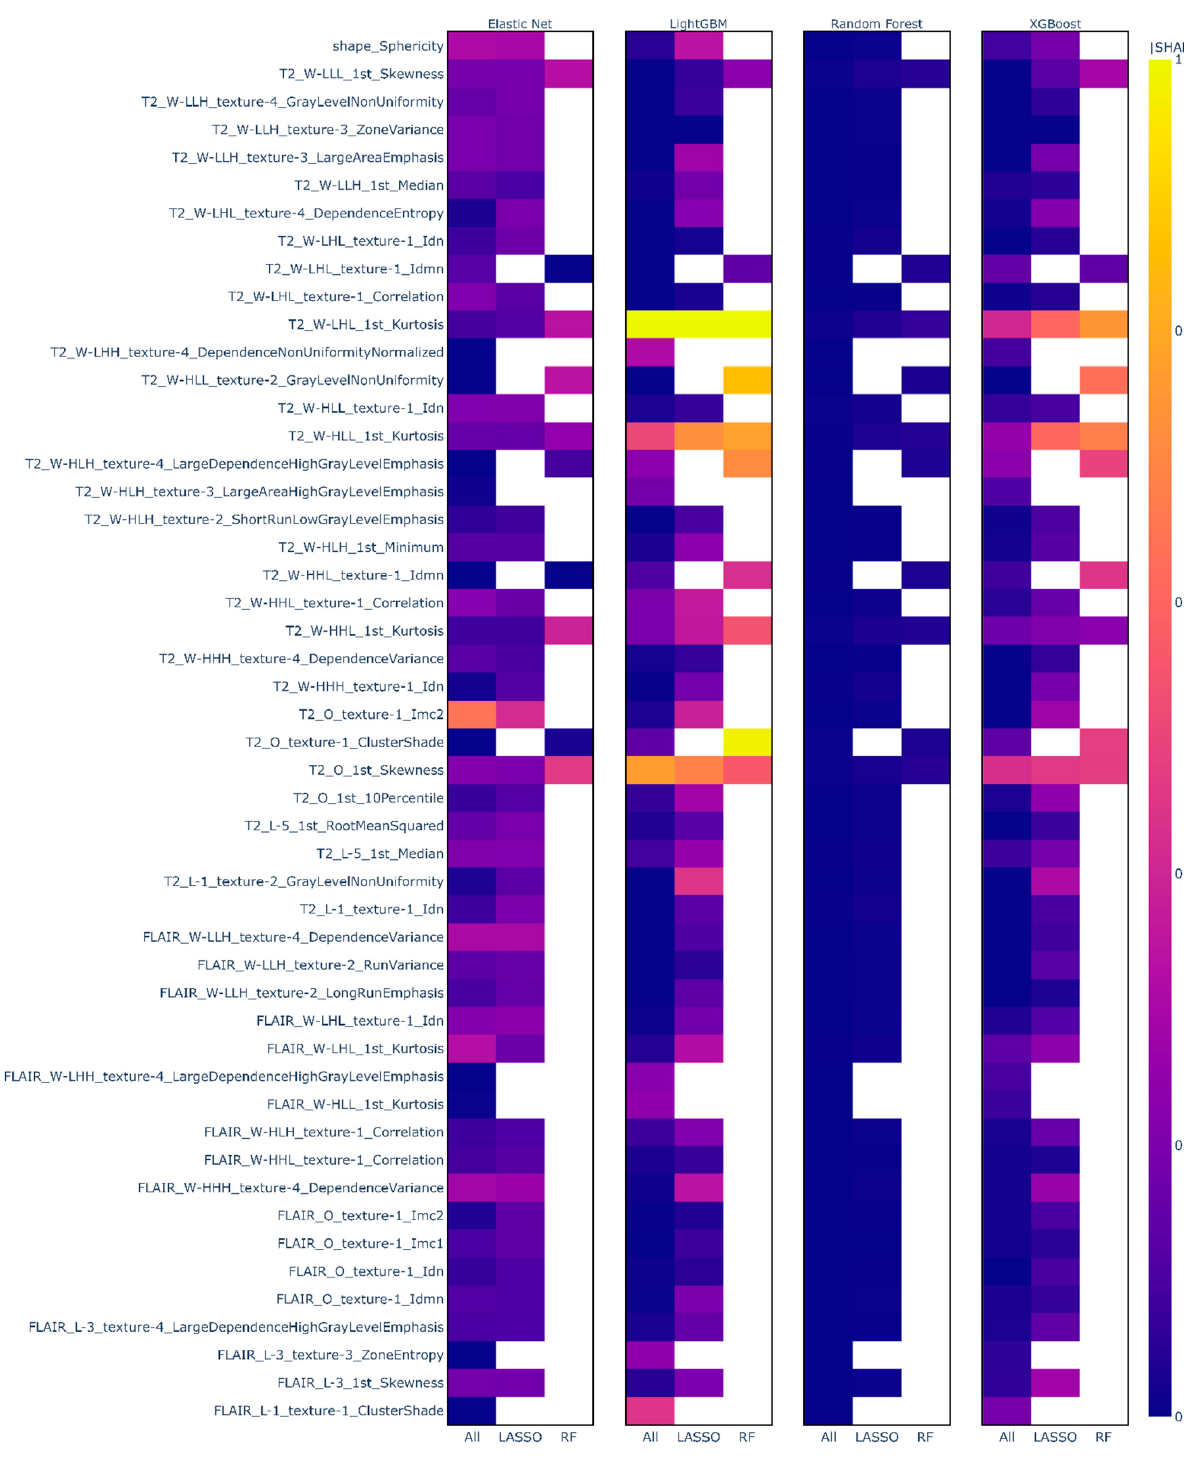
Figure 3. Heatmaps of mean |SHAP| for features by model. Top 50 features by sum of |SHAP| value across all models, sorted by feature similarity. Variable importance is shown by model family and feature subset, either All Features (All), selected by LASSO (LASSO), or Random Forest (RF) recurrent feature elimination. The highest mean |SHAP| values are shown in yellow while lower values are shown in blue on a continuous scale shown to the right. White cells indicate that the feature was not selected for that